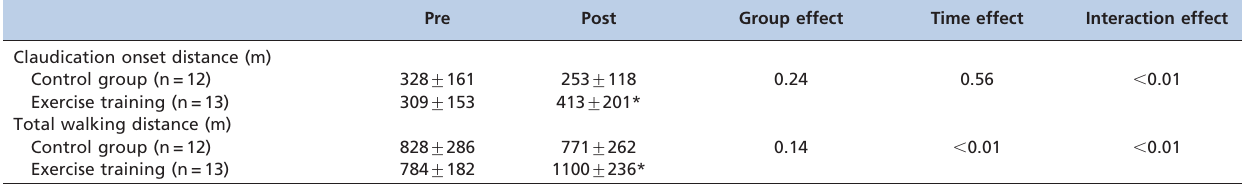
Table 3 - Walking performance in the exercise and control groups. Walking training was prescribed at the heart rate of claudication pain